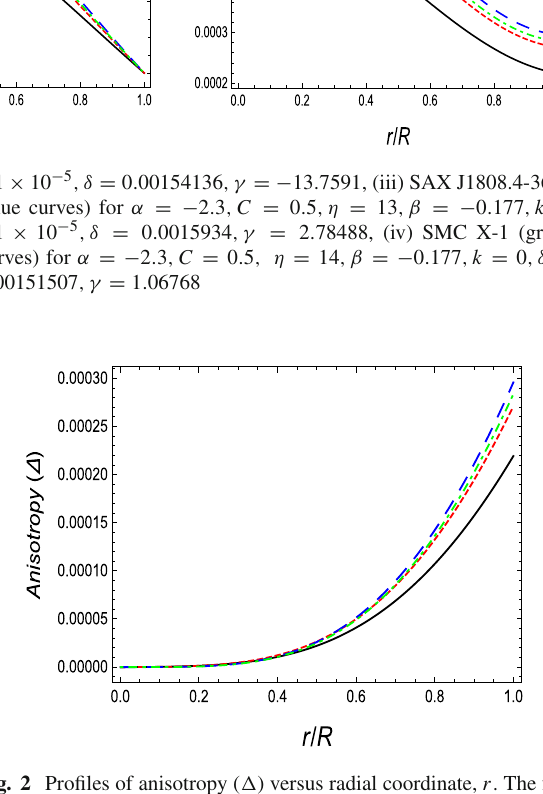
Fig. 2 Profiles of anisotropy ( (cid:24) ) versus radial coordinate, r . The fol- lowing set of numerical values have been used to plot these graphs: (i) Her X-1 (black curves) for α = − 2 . 3 , C = 0 . 5 ,η = 14 ,β = − 0 . 177 , k = 5 . 1 × 10 − 5 ,δ = 0 . 001473 ,γ = − 20 . 6604, (ii) 4U 1538- 52 (red curves) for α = − 2 . 3 , C = 0 . 5 ,η = 15 ,β = − 0 . 177 , k = 4 . 1 × 10 − 5 ,δ = 0 . 00154136 ,γ = − 13 . 7591, (iii) SAX J1808.4-3658 (blue curves) for α = − 2 . 3 , C = 0 . 5 ,η = 13 ,β = − 0 . 177 , k = 6 . 1 × 10 − 5 ,δ = 0 . 0015934 ,γ = 2 . 78488,(iv)SMCX-1(greencurves) for α = − 2 . 3 , η = 14 ,β = − 0 . 177 , k = 0 ,δ = 0 . 00151507 ,γ = 1 .